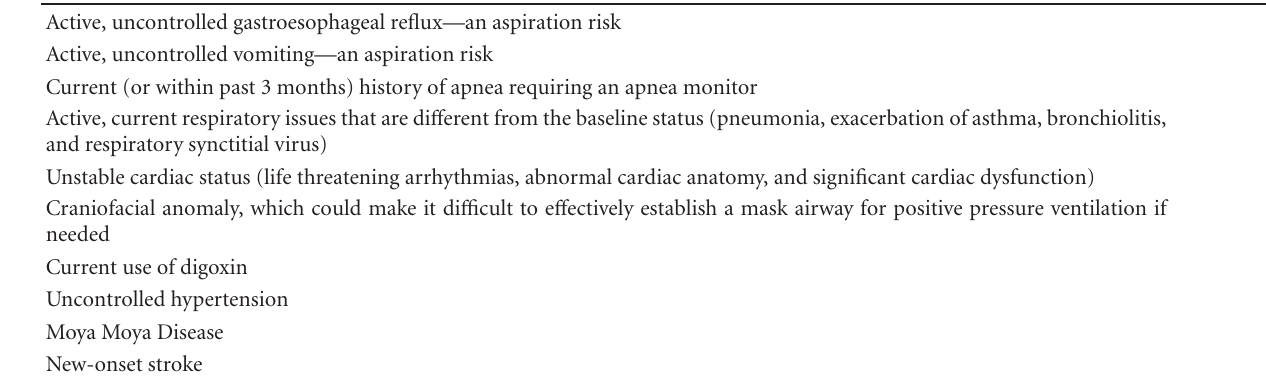
Table 2: Medical Conditions Which Contraindicate Dexmedetomidine